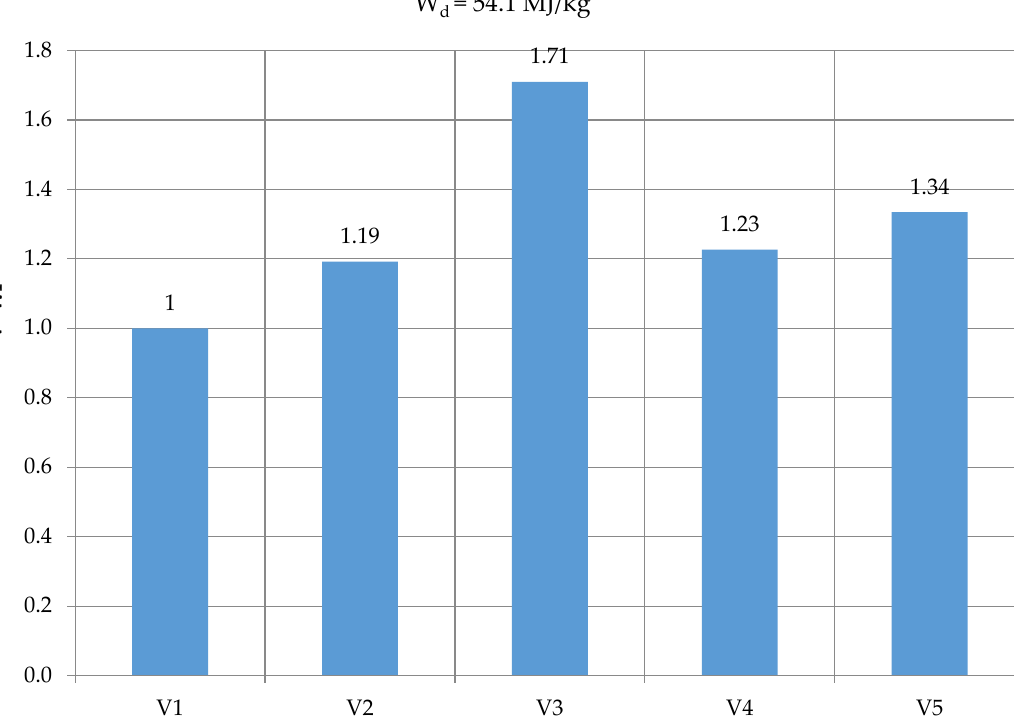
Figure 8. The e ff ect of the cycle structure on its e ffi ciency as compared to variant 1 for heating value Energies 2019 , 12 , x FOR PEER REVIEW Figure 8. The effect of the cycle structure on its efficiency as compared to variant 1 for heating value W d = 38.7 MJ / kg. W d = 38.7 MJ/kg.